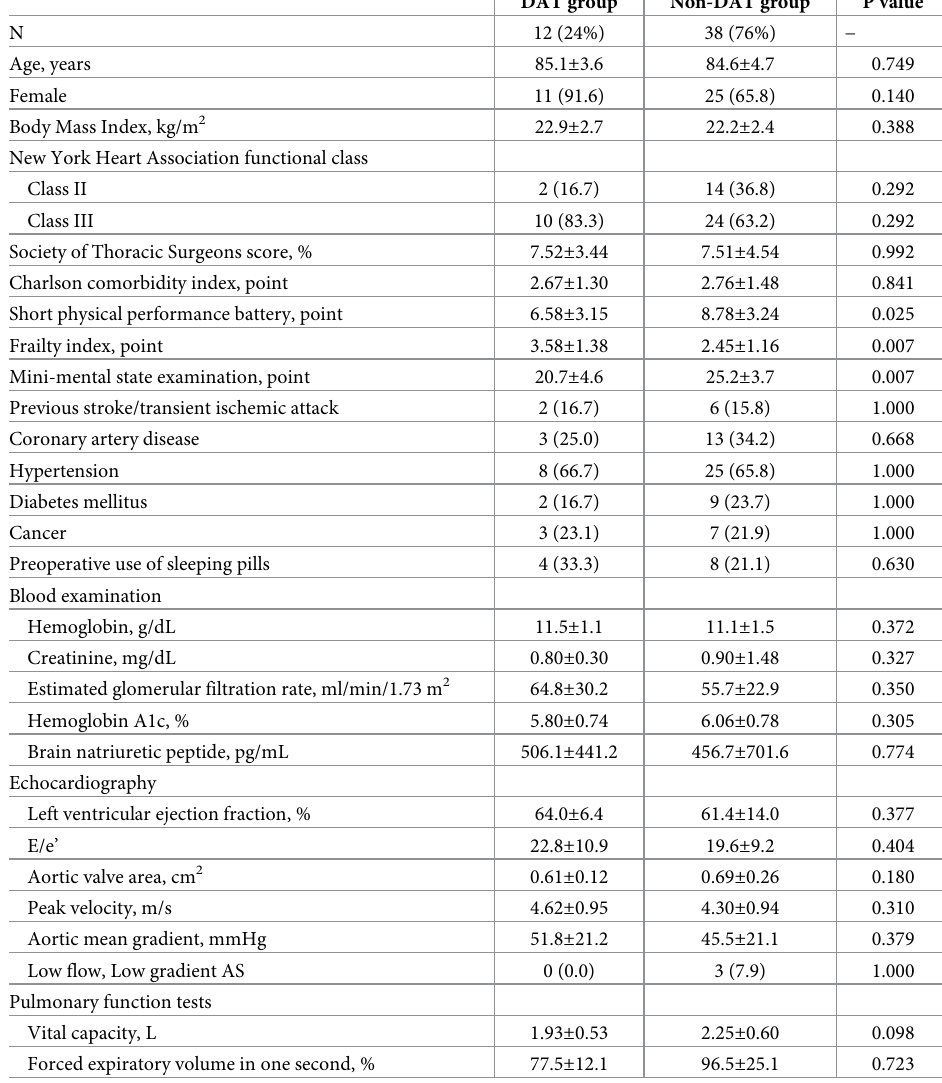
Table 1. Baseline patient